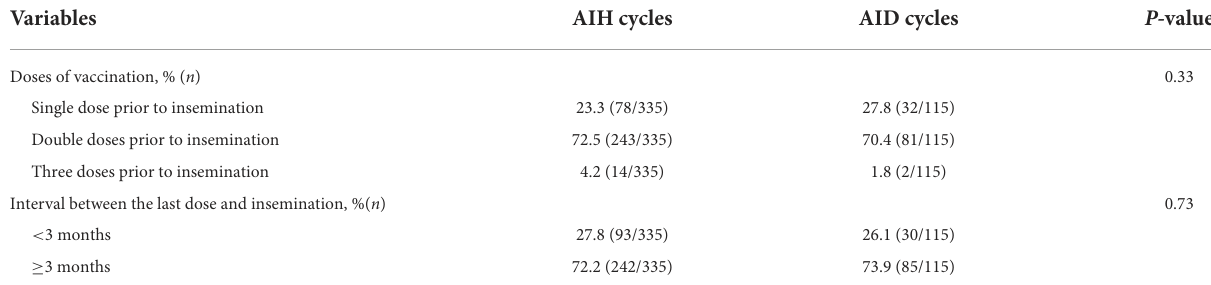
TABLE 2 Vaccination status of vaccines exposed